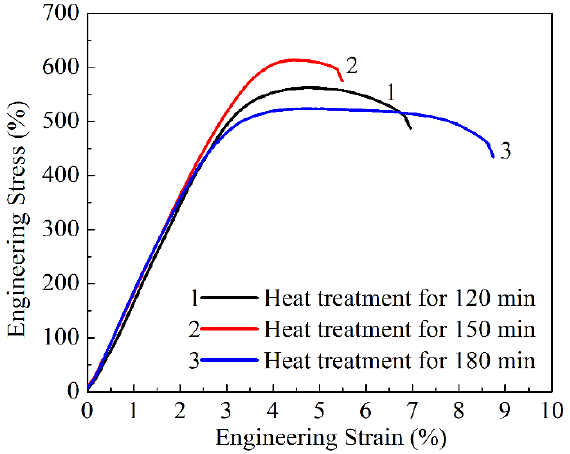
Figure 6. The microstructures and average size of reinforcements in (TiB 2p +TiB w )/Cu composites with different heat treatment time. ( a ) 120 min, ( b ) 150 min, ( c ) 180 min, ( d ) the average size of reinforcements versus heat treatment time.